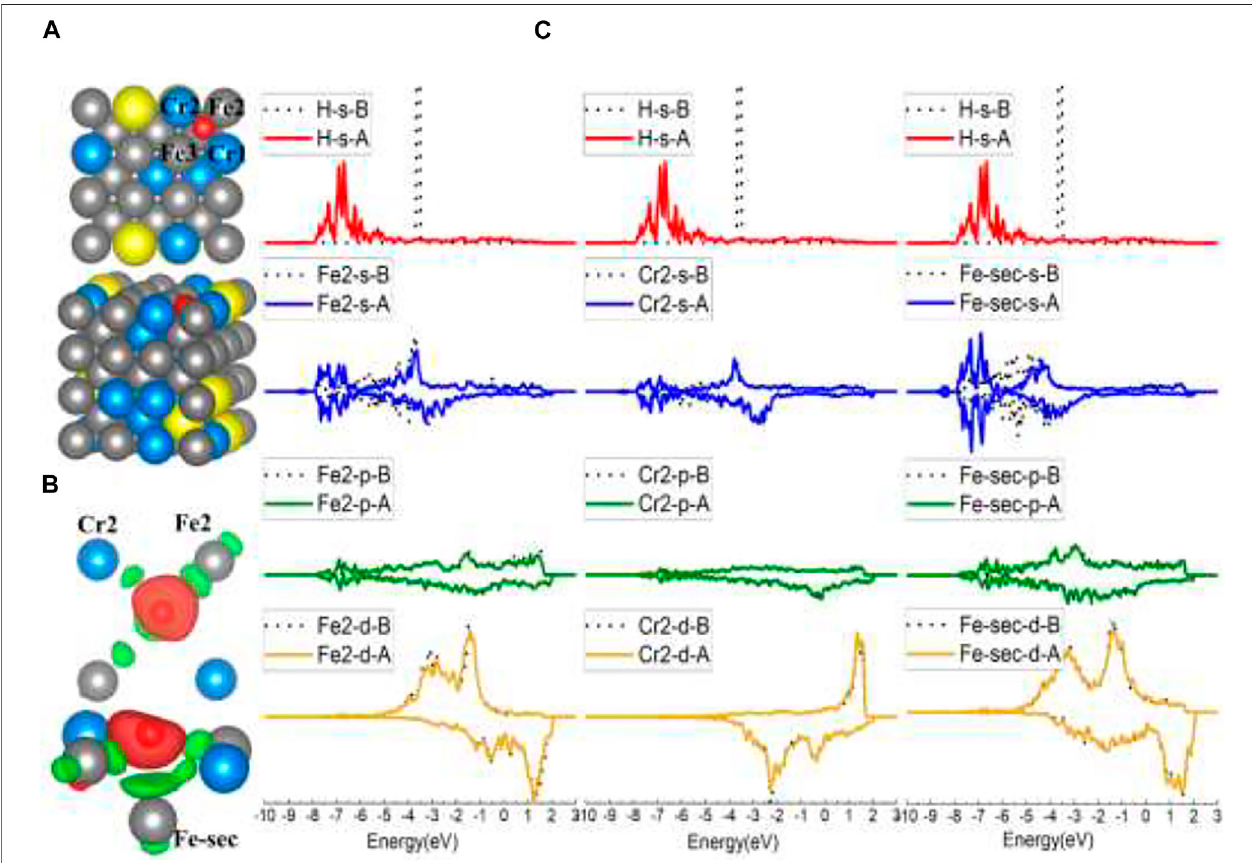
FIGURE7| Theoptimizedstructure,chargedensitydifference,andDOSoftheFe – Cr – Fe – Crfour-foldsiteafterthehydrogenatomisadsorbedontheFeCrAl(100) surface: (A) top and side view of the H-slab structure, (B) charge density difference (the isosurface of charge difference is 0.007 electrons/Bohr 3 ), red color represents charge accumulation, and green color represents charge depletion, and (C) DOS before and after H atom adsorption, the black dotted lines represent s / p / d orbitals before H atom adsorption, and B/A represents before and after,